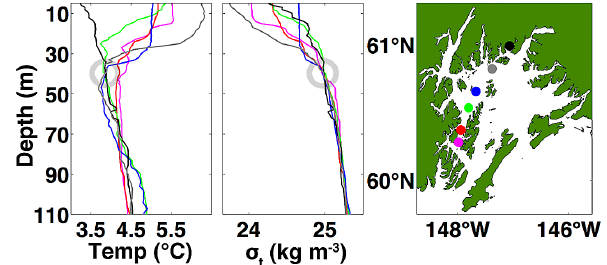
Fig. 9. Spring 2012 depth profiles of temperature ( ◦ C) and σ t (kgm − 3 ). The color of the profiles corresponds to the station po- sitions shown on the map. The mode water with T and σ t charac- teristics is identified with a gray circle in each panel.